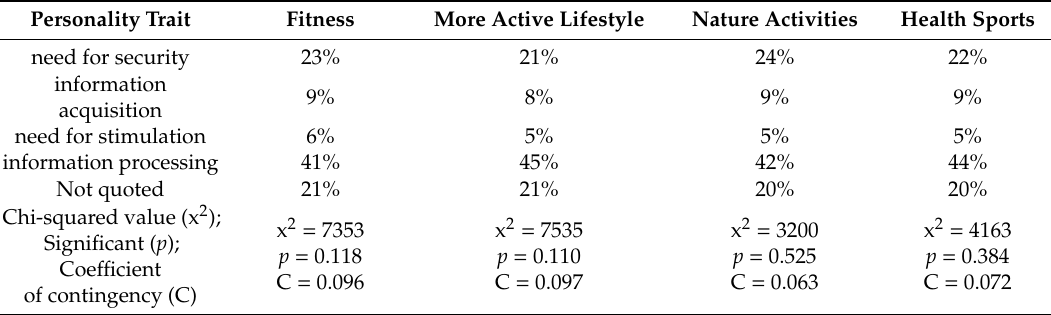
Table 1. Targets for an increase in physical activity depending on personality